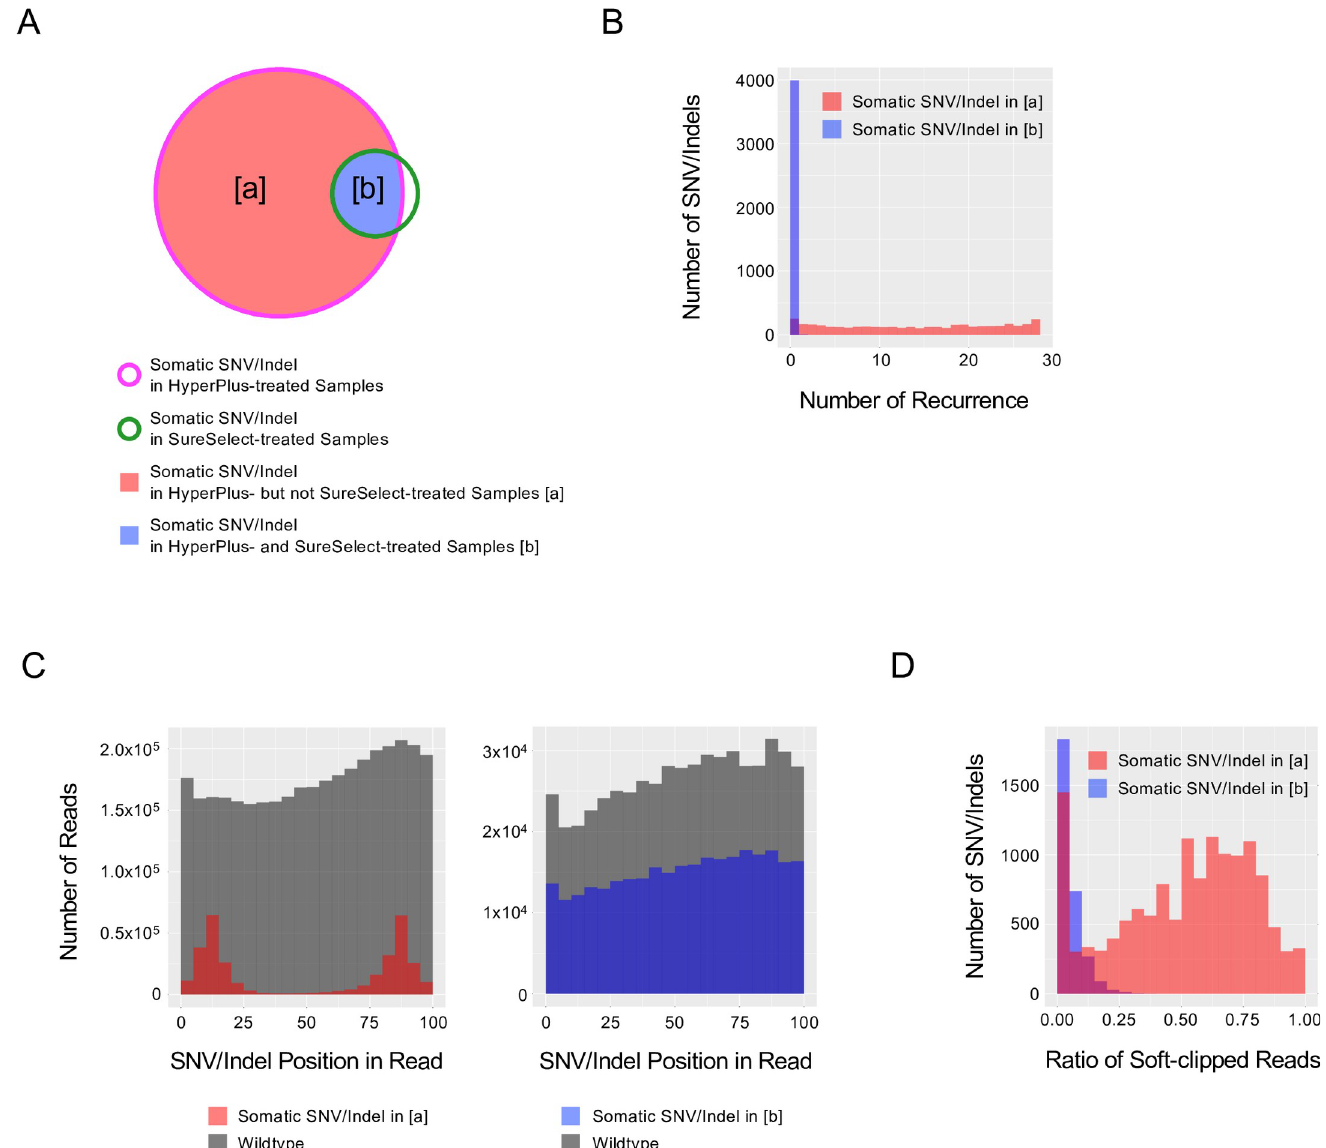
Fig 3. Features of SNV/indel noise caused by the HyperPlus kit. (A) Venn diagram of somatic SNVs/indels detected in the HyperPlus- and SureSelect-treated samples. Magenta and green lines indicate HyperPlus and SureSelect treatments, respectively. The regions [a] (red) and [b] (blue) indicate somatic SNVs/indels detected in the HyperPlus-treated but not the SureSelect-treated samples (red), and those shared by both HyperPlus- and SureSelect-treated samples (blue), respectively. Note: features were extracted from BAM files from libraries prepared with the HyperPlus kit for tumor samples. (B) Histogram depicting recurrence in somatic SNV/indel detection across 28-sample libraries prepared with the HyperPlus kit. X - and y -axes indicate the number of recurrent detections of identical SNVs/indels and the number of SNV/indels, respectively. Red and blue colors indicate somatic SNVs/indels in [a] and [b] in (A), respectively. (C) Histogram for the distribution of SNV/indel position in the read. X - and y-axes indicate the positions of SNVs/indels within 5-bases and the number of reads, respectively. Left panel. Position of somatic SNVs/indels detected in [a] (red). Right panel. Positions of somatic SNVs/indels detected in [b] (blue). The number of wildtype nucleotide reads that mapped to the same genomic coordinate as the detected SNV/indel is indicated in grey. (D) Histogram for the ratio of the soft-clipped reads. X - and y -axes indicate the ratio of soft-clipped reads at 0.05 intervals and the number of SNV/indels,